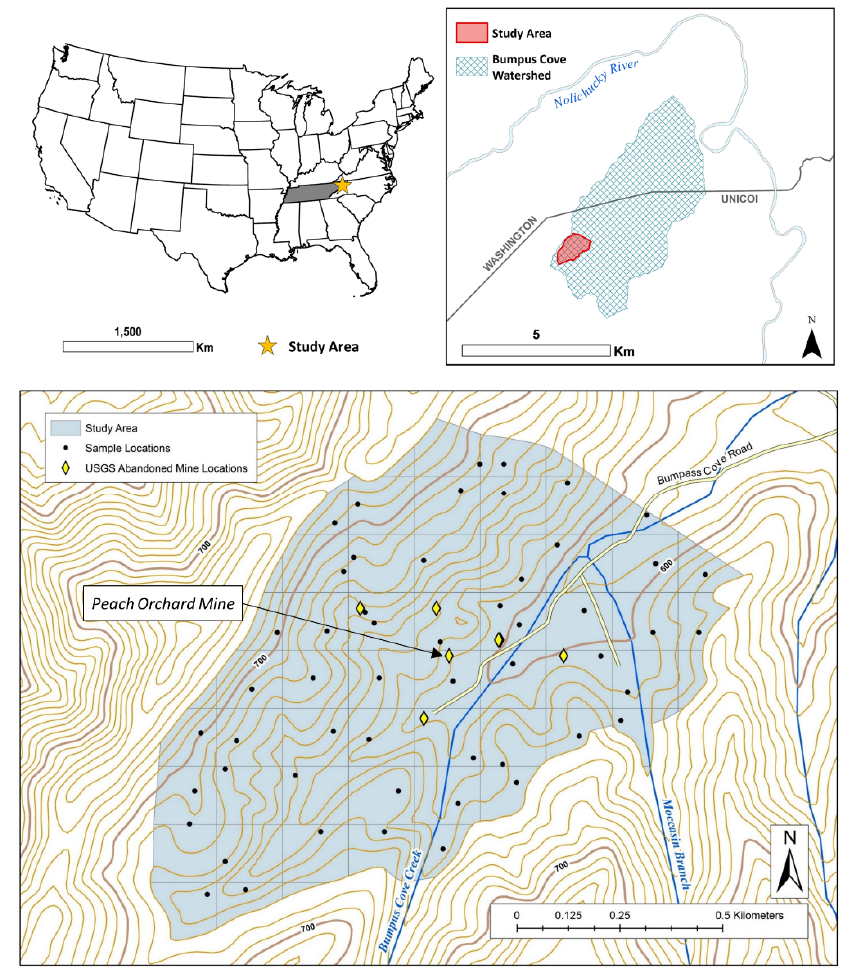
Figure 1. Bumpus Cove study area (0.67 km 2 ) in northeast TN, USA, showing topographic contours and mine and sample locations.